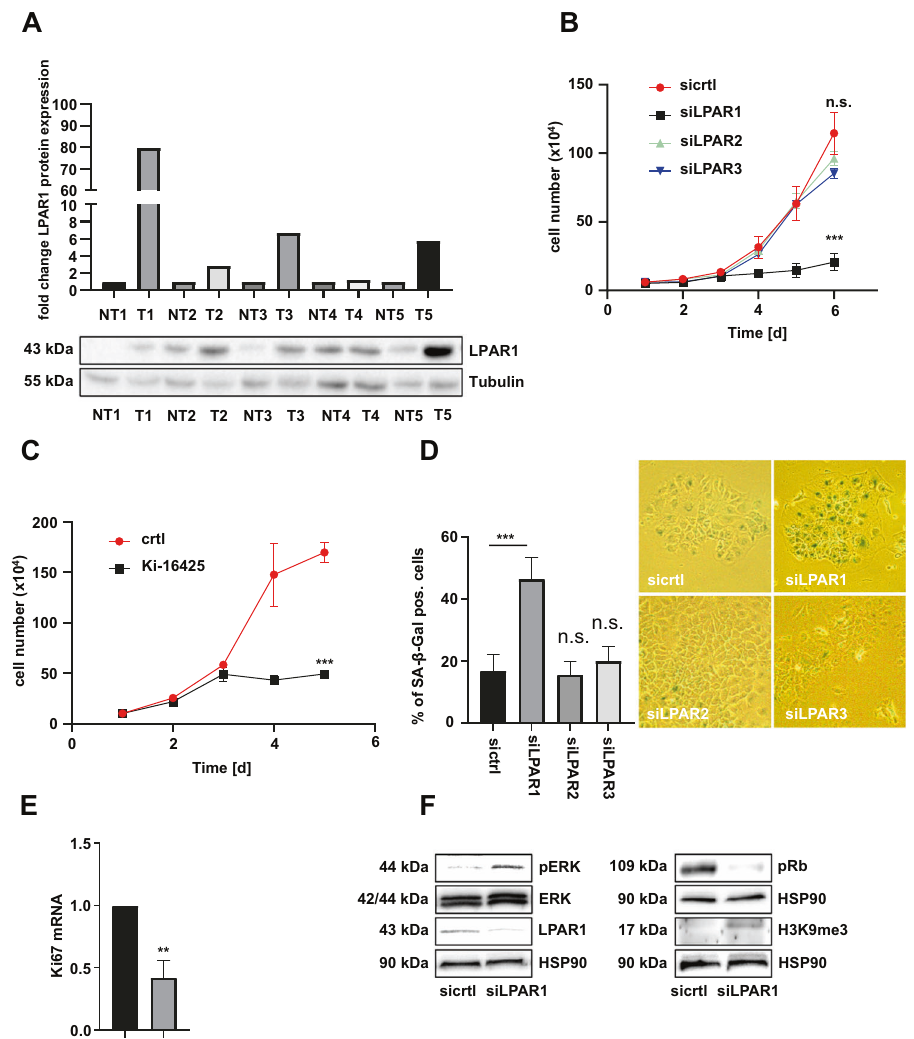
Fig. 1 LPAR1 as a novel modulator of HCC cell proliferation and senescence. A Relative LPAR1 protein expression in human HCC tissue samples. Alternating non-tumorous (NT) and tumorous (T) samples, extracted from the same patients, were immunoblotted using anti-LPAR1 or anti-Tubulin antibody as a loading control and normalized to the non-tumorous sample. B HuH7 cells transiently transfected with LPAR1, LPAR2, and LPAR3 (siLPAR1, siLPAR2, and siLPAR3) siRNA or negative control (sicrtl), were counted daily for 6 days. Values are means ± SD ( n = 3); *** p < 0.001. C HuH7 cells treated with or without Ki-16425 (20 µM) were counted daily for 5 days. Values are means ± SD ( n = 3); *** p < 0.001. D Quanti fi cation of senescence-associated β -galactosidase (SA- β -gal) staining of HuH7 cells expressing LPAR1, LPAR2, and LPAR3 (siLPAR1, siLPAR2, and siLPAR3) siRNA and negative control siRNA (sicrtl) for 6 days (left). Representative pictures of SA- β -gal staining (right). Number of SA- β -gal positive blue cells was counted. Values are mean ± SD ( n = 3); *** p < 0.001. E HuH7 cells transfected with negative control siRNA (sicrtl) or LPAR1 siRNA (siLPAR1) were subjected to qRT-PCR. Ki67 primers were used and normalization to the 18S rRNA was carried out. Values are means ± SD ( n = 3); ** p < 0.01. F Immunoblotting in lysates of HuH7 cells, harvested 6 days after transfection with negative control siRNA (sicrtl) or LPAR1 siRNA (siLPAR1) for pERK, ERK, LPAR1, and HSP90 (left), pRb, H3K9me3, and HSP90